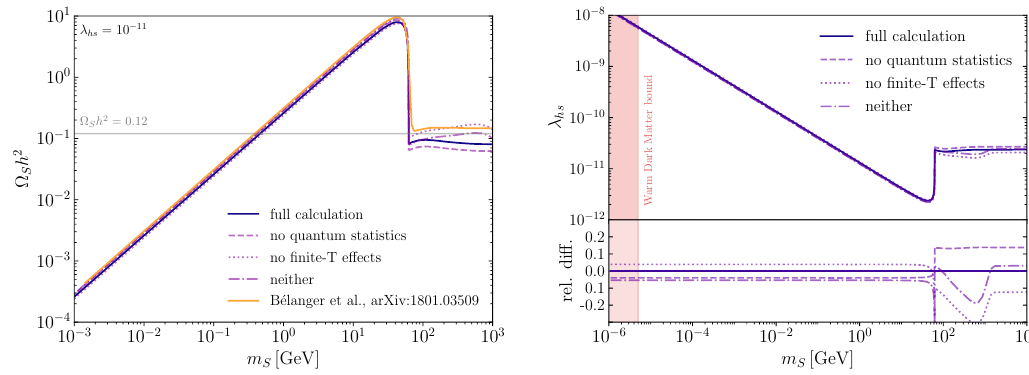
Figure 5 . Left: relic density Ω h 2 as a function of the scalar singlet mass m S for a fixed value of the portal coupling λ hs = 10 − 11 in the case of a high reheating temperature. We compare the results obtained from DarkSUSY (purple lines) with the ones obtained in ref. [3], which includes quantum statistics using micrOMEGAs but no (other) thermal effects. Right: portal coupling λ hs needed to reproduce the observed DM relic abundance Ω S h 2 = 0 . 12 as a function of m S . The smaller panel in the bottom shows the relative difference when the various effects considered in this work are switched